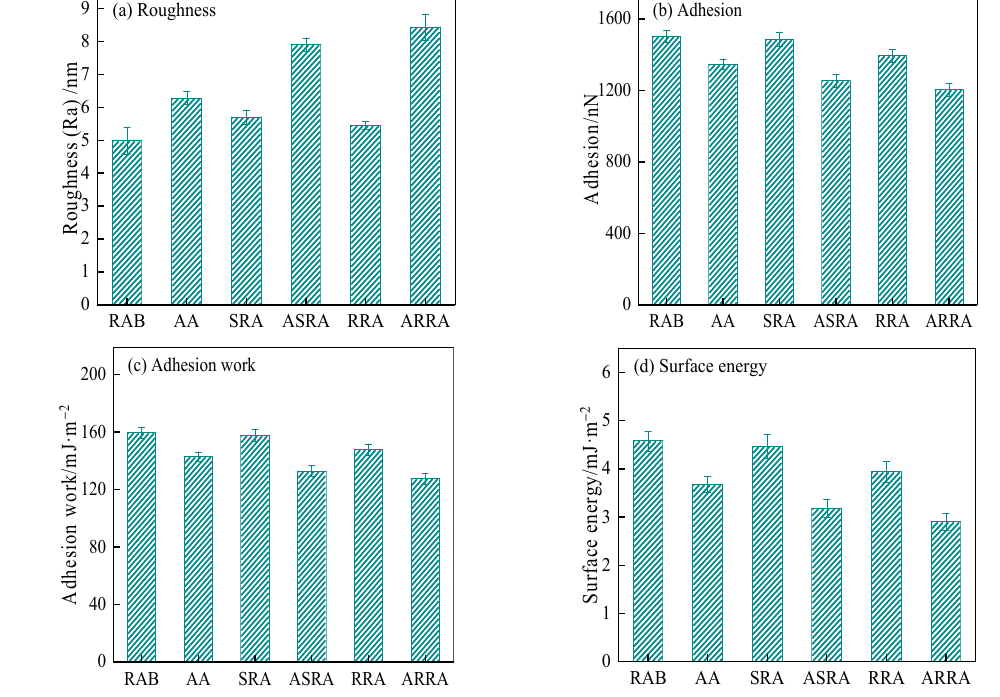
Figure 8. Microstructure parameters of asphalt binders.